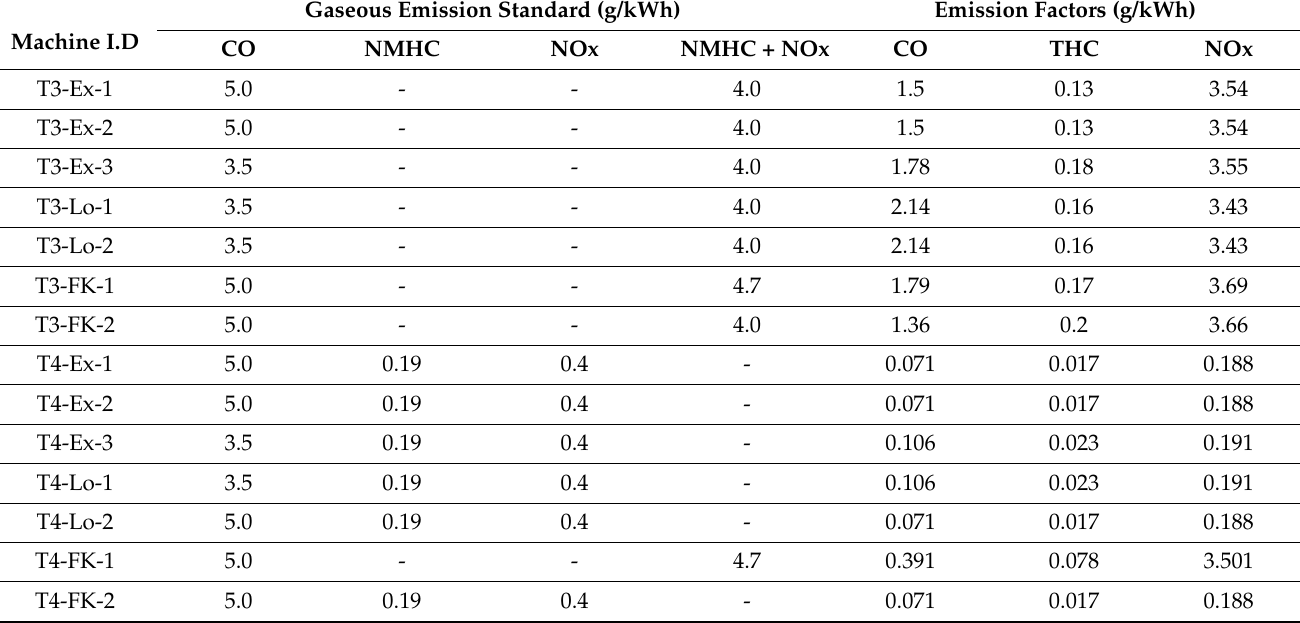
Table 2. Standard of gaseous emissions and emission factor with concern of construction machines